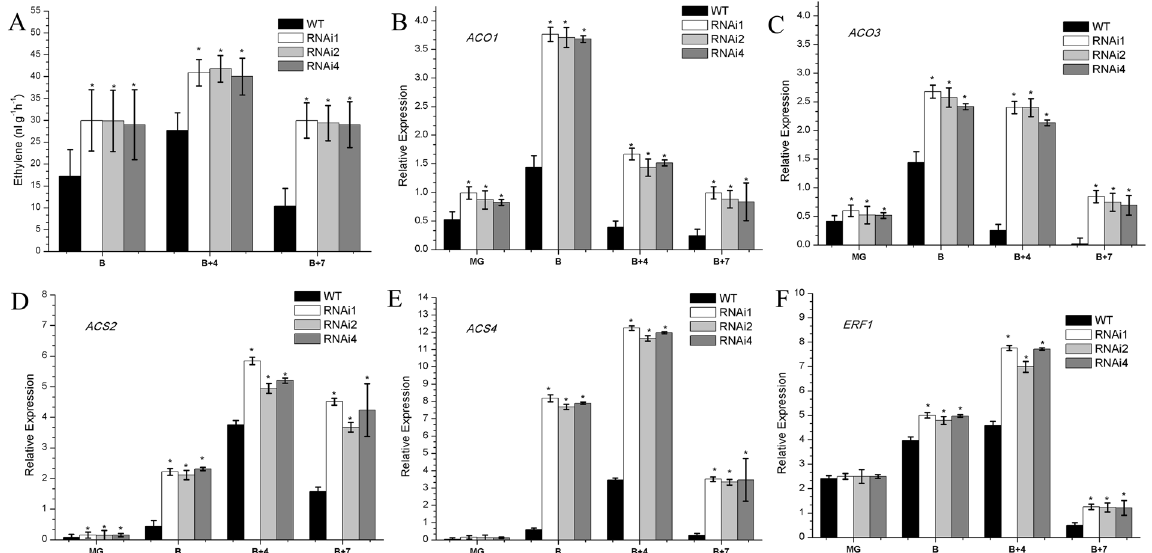
Figure 4. ( A ) Ethylene production and ( B ) to ( F ) relative expression profiles of ethylene biosynthesis related genes ACO1 , ACO3 , ACS2 and ACS4 and the ethylene response factor ERF1 in the pericarp between wild type (WT) and SlHDA1 RNAi fruits. Ethylene production of WT and transgenic fruits was detected at the indicated stage ( B , B + 4 and B + 7). Three biological replications and three technical replications for each sample were performed. Data are the means ± SD of at least three individual fruits. MG, mature green; B, breaker; B + 4, 4 d after breaker stage; B + 7, 7 d after breaker stage. Gene relative expression data are the means ± SD of three independent experiments. The asterisks indicate statistically significant differences between the WT and transgenic fruits (P < 0.05).